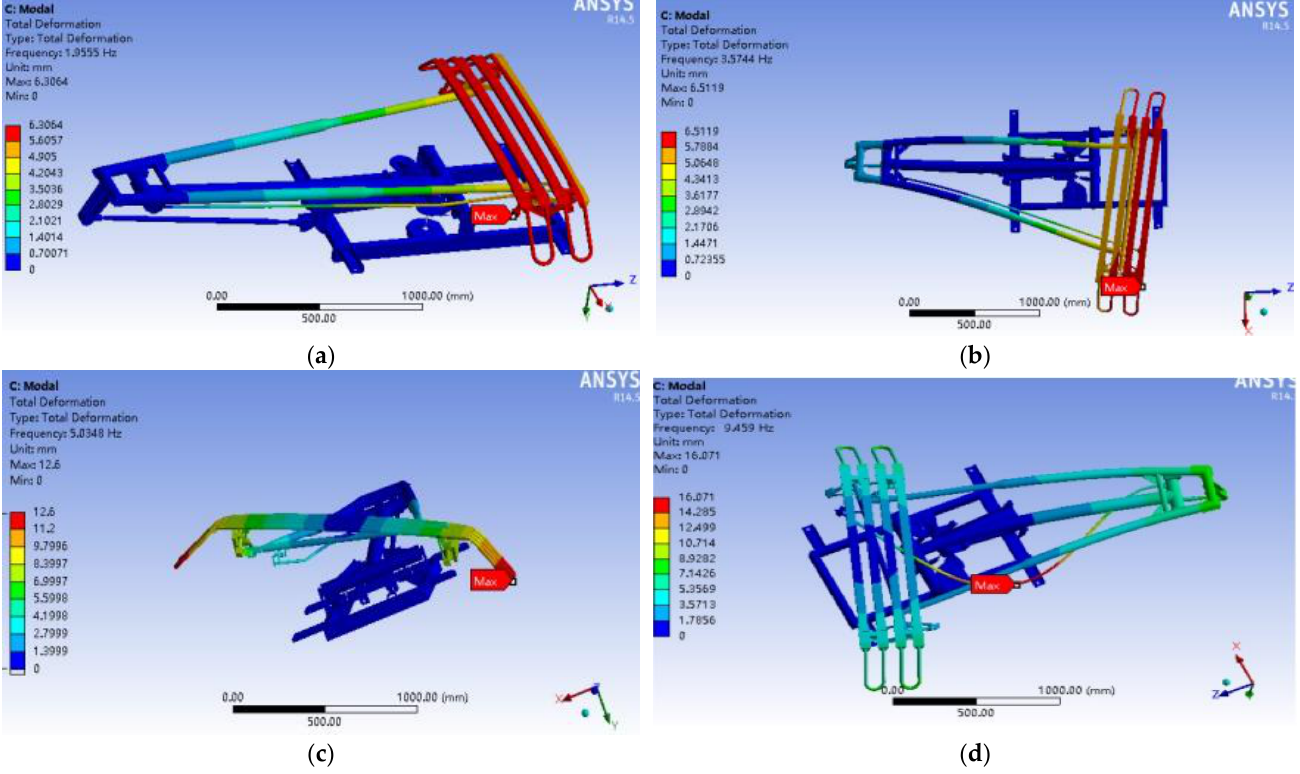
Figure 11. Modal frequencies and mode shapes of a pantograph frame. ( a ) First mode, 2.0 Hz. ( b ) Second mode, 3.6 Hz. ( c ) Third mode, 5.1 Hz. ( d ) Fourth mode, 9.4